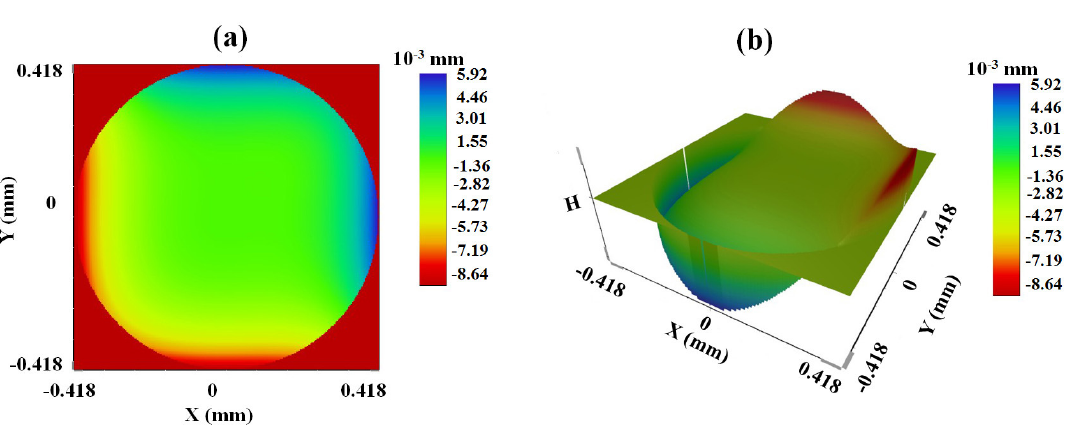
Figure 5. Structure of the proposed phase mask. ( a ) 2D map. ( b ) 3D map.